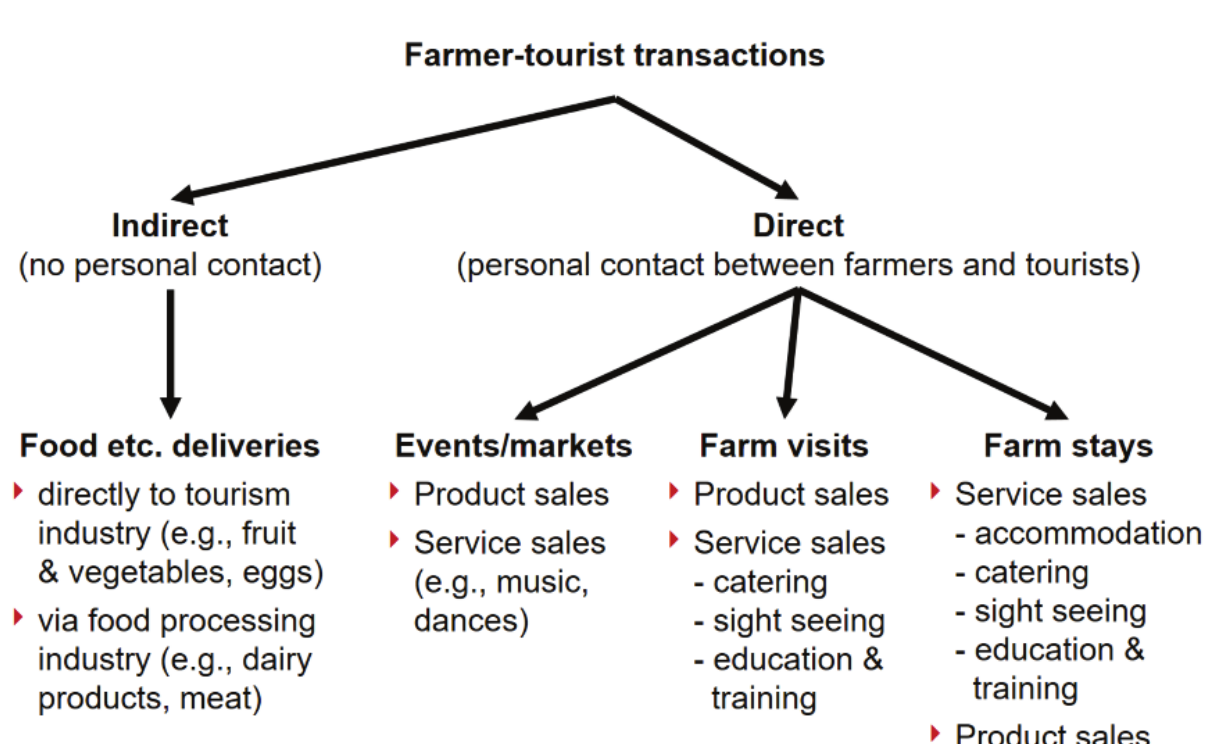
Figure 1 : The in-country transaction interface between farmers and